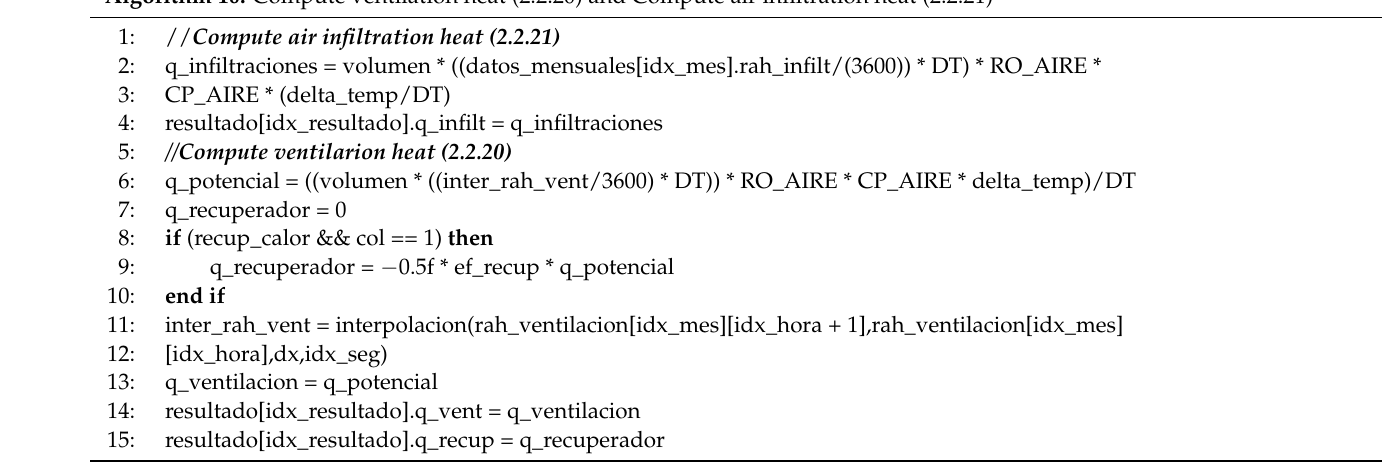
Algorithm 10. Compute ventilation heat (2.2.20) and Compute air infiltration heat (2.2.21)